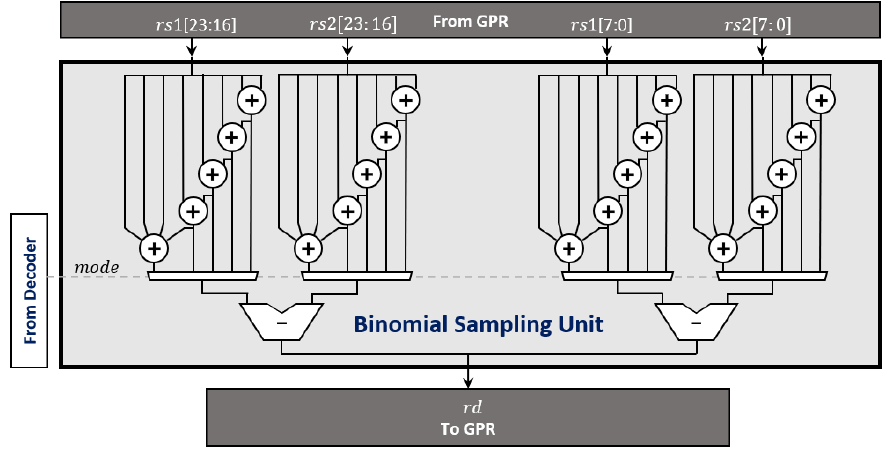
Figure 6: Binomial Sampling